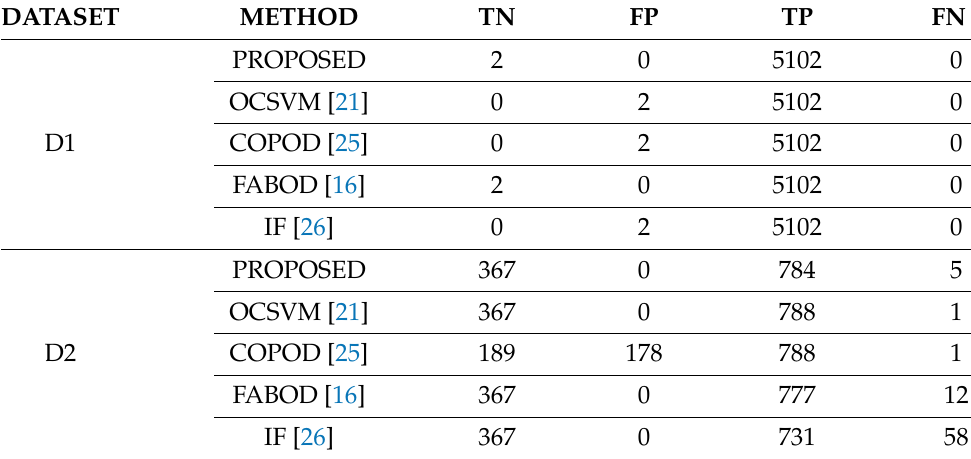
Table 2. Comparison for Datasets D1 and D2 of our proposed method (PROPOSED) with several classic anomaly detection methods: OCSVM, COPOD, FABOD, and IF. The comparison is presented as a benchmark of confusion matrices, reporting True Negative (TN), False Positive (FP), True Positive (TP), and False Negative